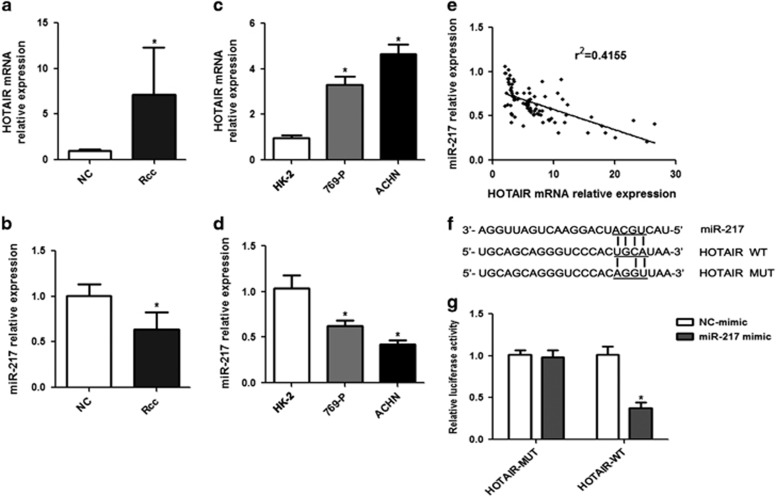
The expression of HOTAIR and miR-217 in Rcc tissues and cells and the relationship between HOTAIR and miR-217. qRT-PCR for the expression of HOTAIR (a) and miR-217 (b) in Rcc tissues and adjacent histological normal tissues. Data were analyzed by paired Student’s t-test. The expression levels of HOTAIR (c) and miR-217 (d) were assayed in Rcc cells (769-P and ACHN) and normal kidney cells (HK-2). The expression of HOTAIR and miR-217 was normalized to that in HK-2. The differences between groups were analyzed by unpaired Student’s t-test. (e) Bivariate correlation analysis of the relationship between HOTAIR expression and miR-217 level. (f) The putative miR-217 binding sequence of the wild type and mutation sequence of HOTAIR. (g) Relative luciferase assays. Statistical analysis was conducted using unpaired Student’s t-test. *P<0.05